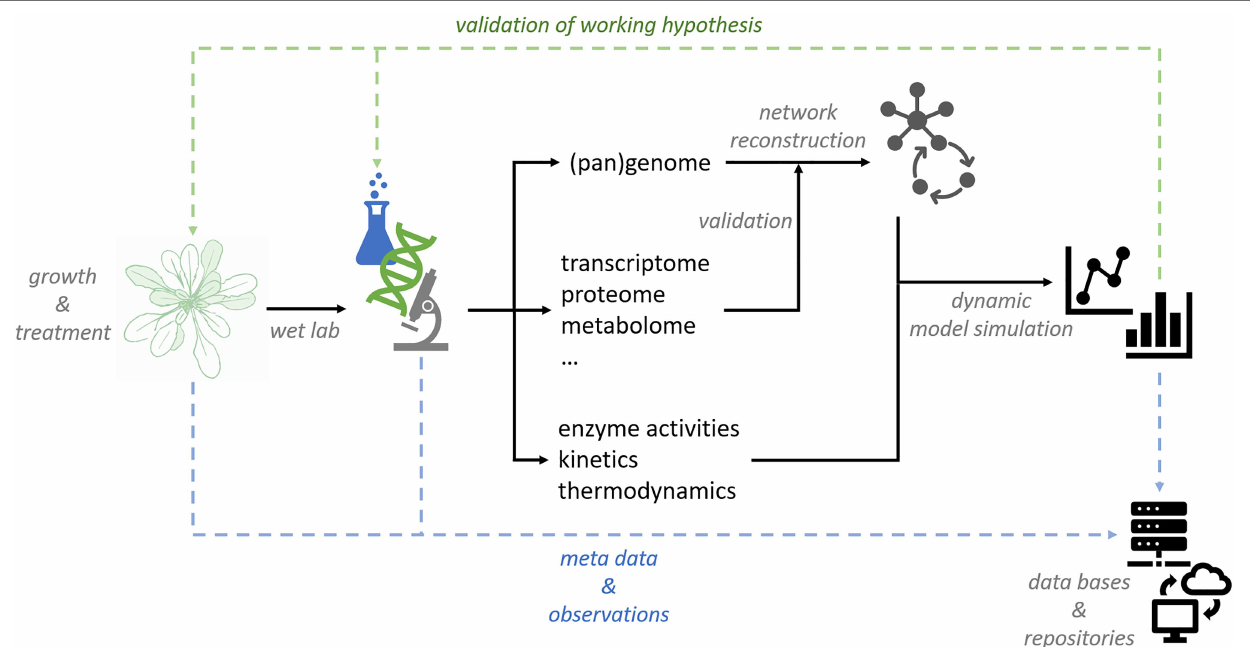
FIGURE 3 | Conceptual workflow for data management and modeling in plant